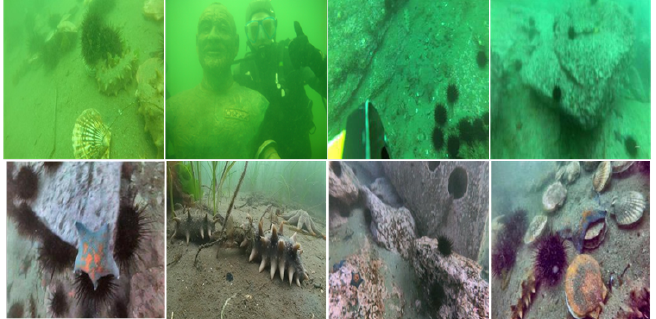
Figure 1. The Unpaired underwater images dataset. The top row displays the degraded underwater images, and the bottom row shows the clear ones. Both rows are